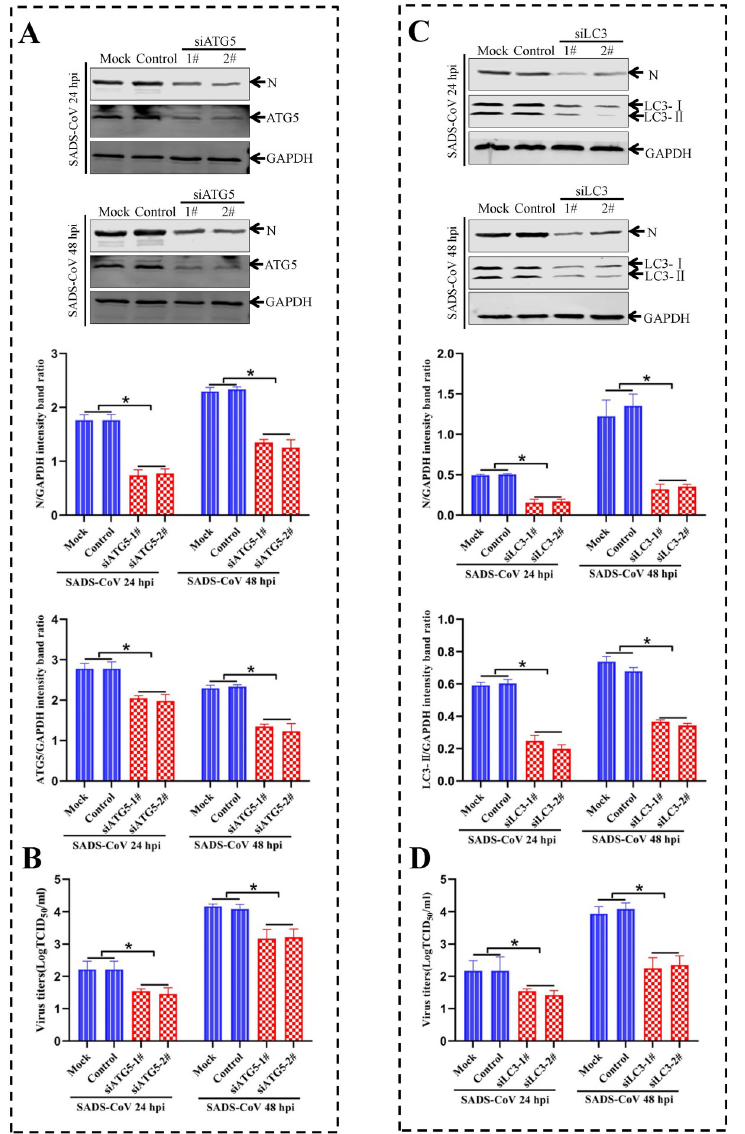
Fig 3. Knockdown of endogenous ATG5 or LC3 genes inhibits the replication of SADS-CoV. ( A and B ) ST cells treated with Mock, Control siRNA (Control) or siATG5 for 48 h, and followed by an infection with SADS-CoV for 24 and 48 h, respectively. The cellular lysates are analyzed by western blotting with anti-viral N, anti-ATG5, or anti- GAPDH antibodies, and the viral titers are determined. ( C and D ) ST cells treated with Mock, Control siRNA (Control), or siLC3 for 48 h, and followed by an infection with SADS-CoV for 24 and 48 h, respectively. The cells are analyzed by western blotting with anti-viral N, anti-LC3, or anti-GAPDH antibodies and the viral titers are determined. Means and SD (error bars) of three independent experiments are indicated ( � P <